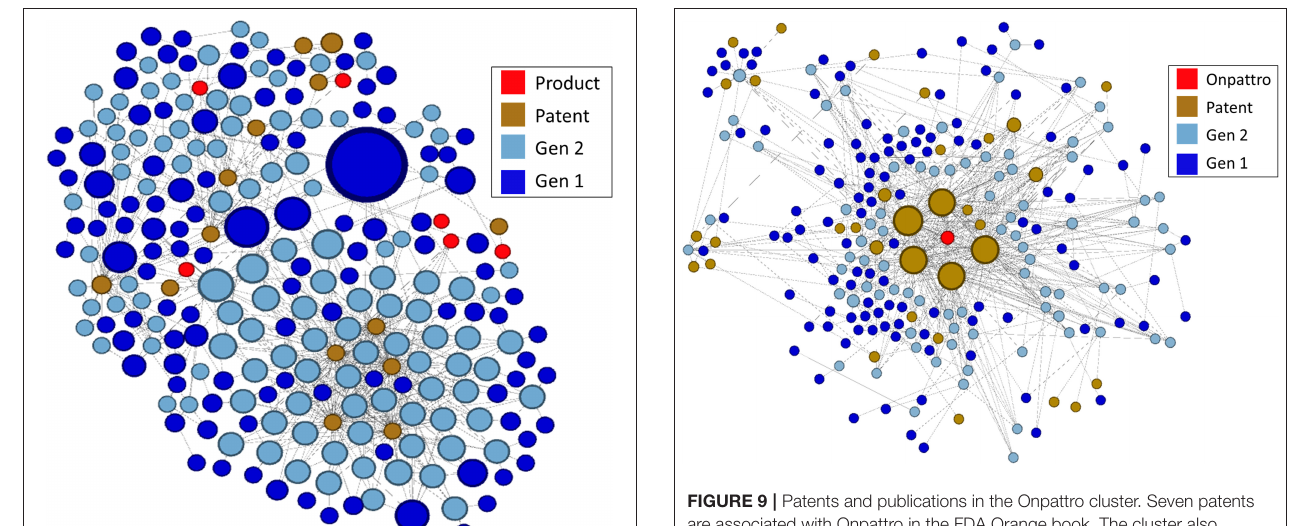
representing 6.4 percent of the 6,843 unique trade-named drug information in the Orange Book.